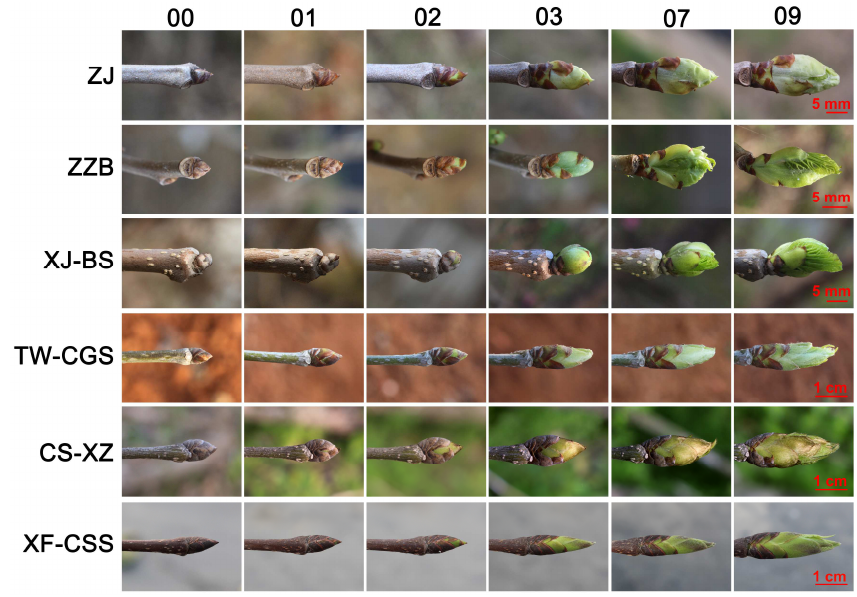
Figure 1. Stages of bud development for mulberry according to the BBCH scale. Buds are densely covered with hairs in CS-XZ.